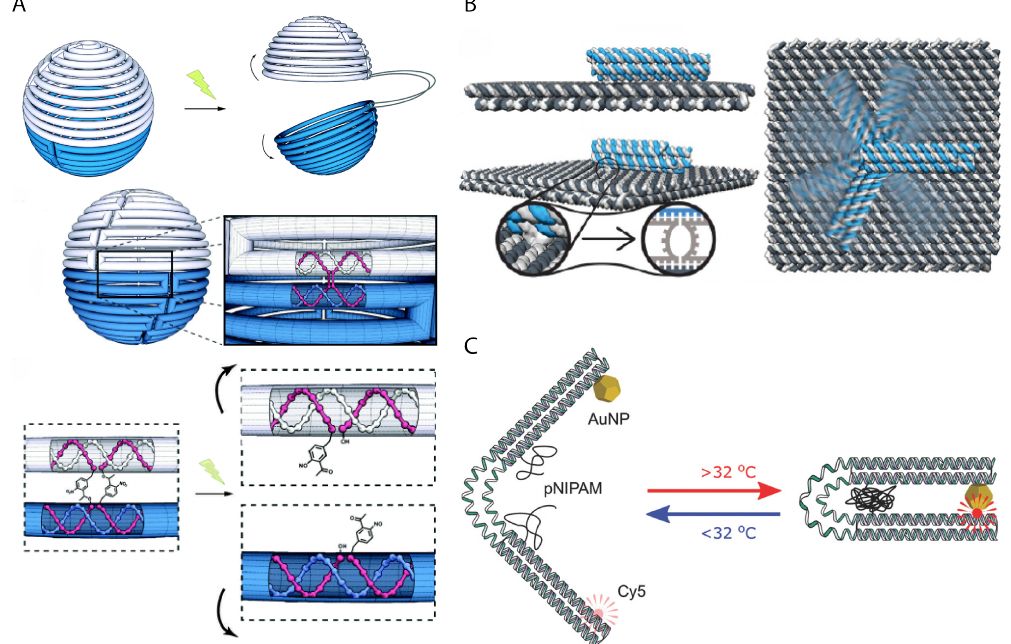
Figure 4. Signal-responsive actuation of DNA nanomechanics. ( A ) A light-responsive spherical DNA capsule with a photo-cleavable site (reprinted with permission from The Royal Society of Chemistry [68]); ( B ) A DNA origami arm that can be controlled by an external electric field (reprinted with permission from AAAS [72]); ( C ) A hinged DNA nanostructure that places polymers with temperature-responsive hydrophobicity on opposite facing sides of the hinge. Above a specific temperature threshold, the polymers aggregate due to hydrophobic interactions and pull the DNA nanostructure into a closed conformation (reprinted with permission from Wiley-VCH